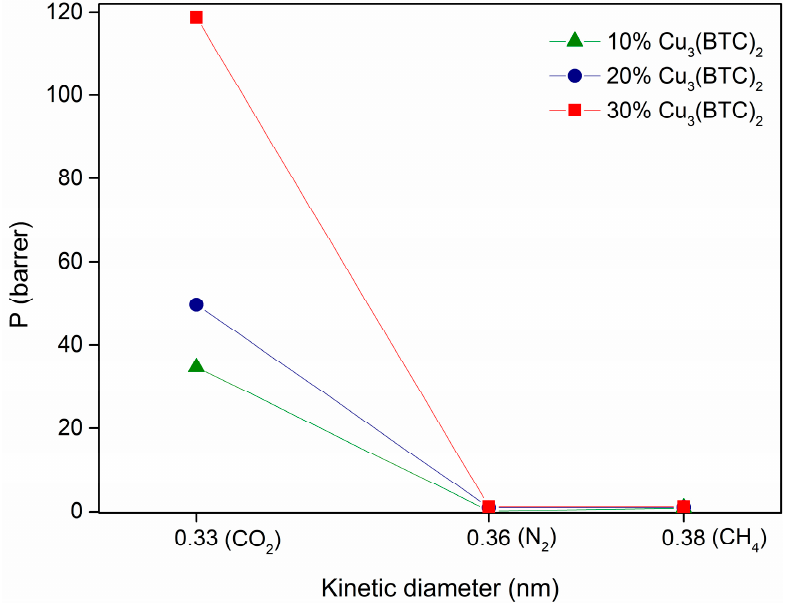
Figure 7. Evolution of gas permeability as a function of the gas kinetic diameter for MMMs prepared with different loadings of Cu-BTC (between 10 and 30% w/w ).